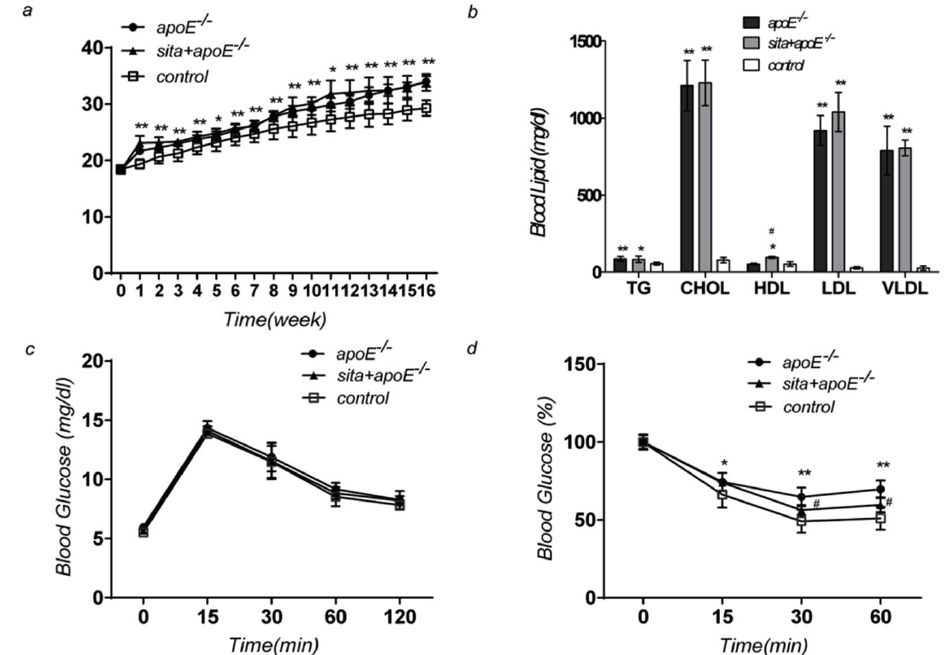
Figure 1. Effect of sitagliptin on body weight, blood glucose level, serum lipid level, and insulin sensitivity. ApoE − / − , sita + apoE − / − and control groups were tested at week 16 for changes in ( a ) body weight; ( b ) serum lipid; ( c ) intraperitoneal glucose tolerance test; ( d ) intraperitoneal insulin tolerance test. Values are reported as mean ± S.D. * p < 0.05 and ** p < 0.01 vs. control group at same time points; # p < 0.05 vs. sita + apoE − / −